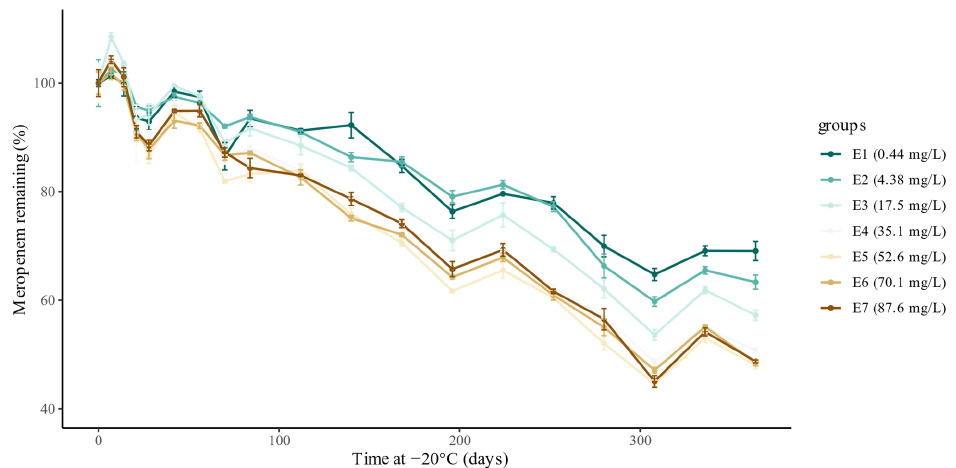
Figure 1. Experimentally measured degradation relative to the initial concentration (%), for each spiked concentration. The dots represent the mean concentration (%) in the three samples, and the bars represent the standard error for each mean. Table 2. Results of the ordinary least-squares polynomial regression (POLY) and artificial neural network (ANN). All statistics and metrics were derived from predictions on the left-out test experi- ment, i.e., measured concentrations that the model has never seen. Means of the metrics are provided with their standard deviation (SD). The root-mean-square error (RMSE) between the predictions and experimental measurements was less than 6% for all